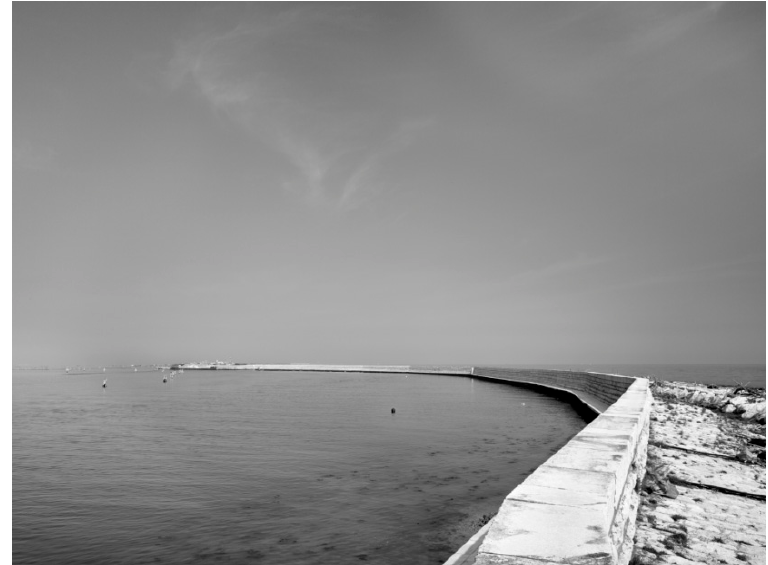
Figure 11. Photo of the sandbanks of Pellestrina from the exhibition “Senza Pericolo” (Triennale 2013) by Marco Introini. Courtesy of the Author.